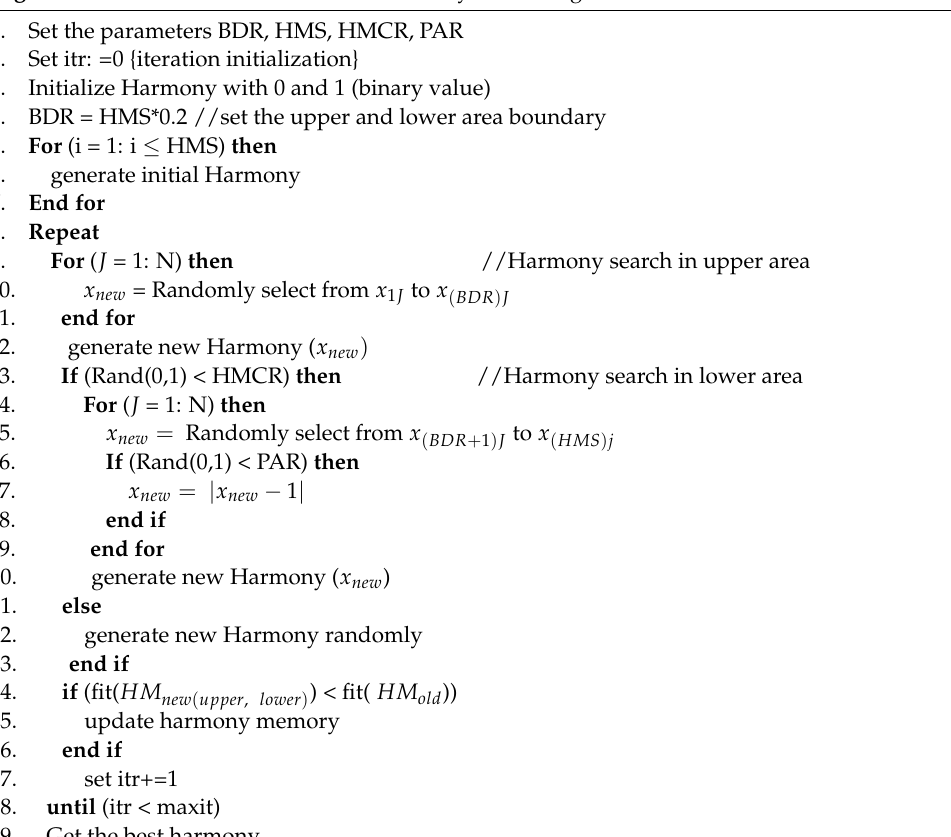
Algorithm 1. Pseudocode of Modified Harmony Search